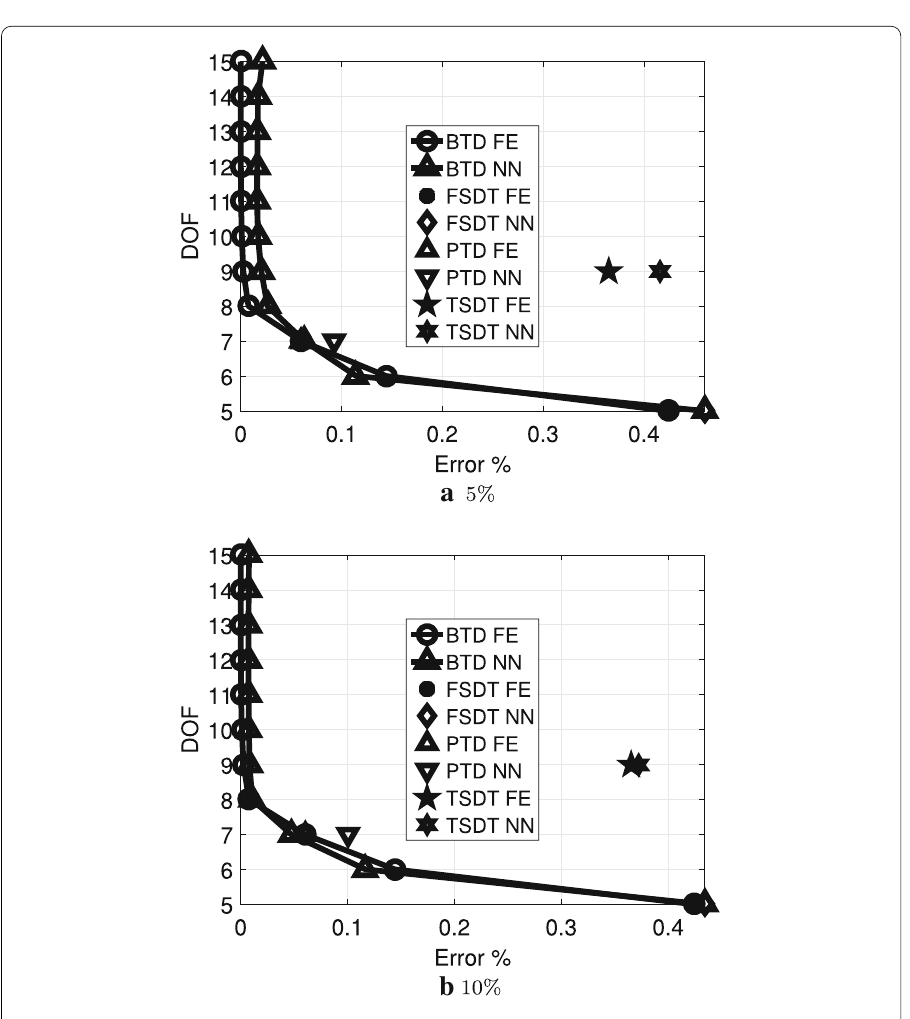
Fig. 6 FE and NN results for 0/90/0, a/h = 100, one layer, influence of the number of the training set size